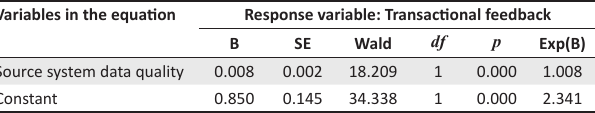
TABLE 5: Logistic regression of transactional data quality on transactional feedback.